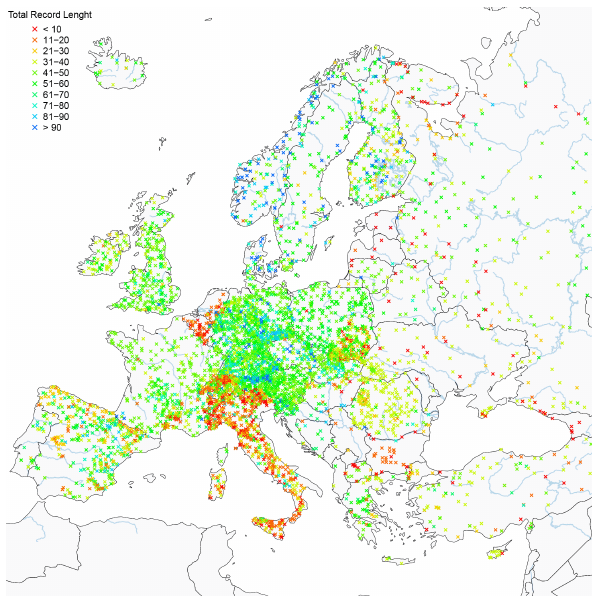
Figure 3. Station altitude [m.s.l.].